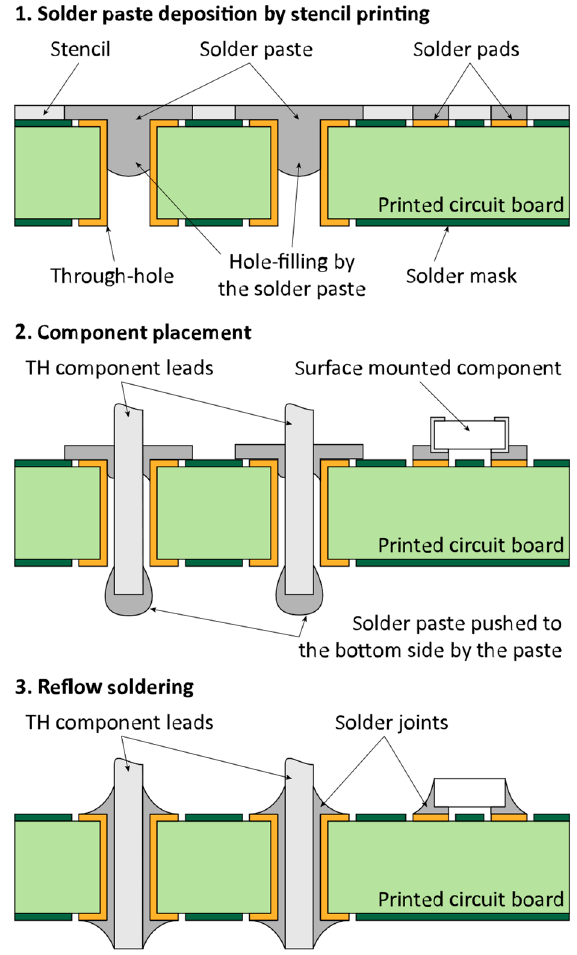
Figure 1. Schematic of the steps of pin-in-paste technology.